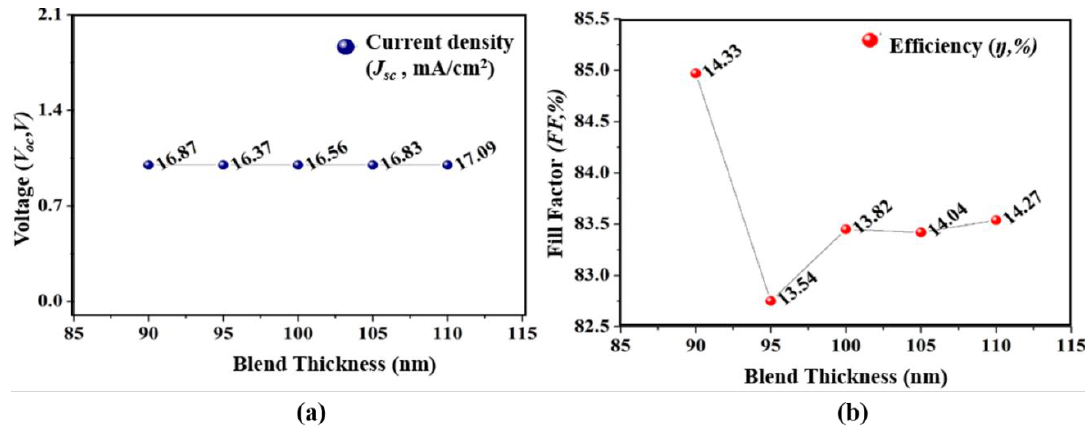
Figure 4. Effect of third absorber layer thickness on photovoltaic parameters. ( a ) V oc and J sc ; ( b ) FF and η .